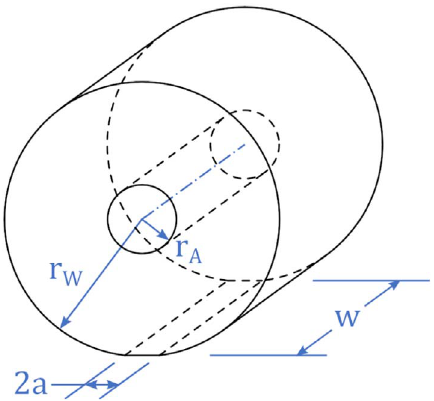
Figure 1. Description of the wheel